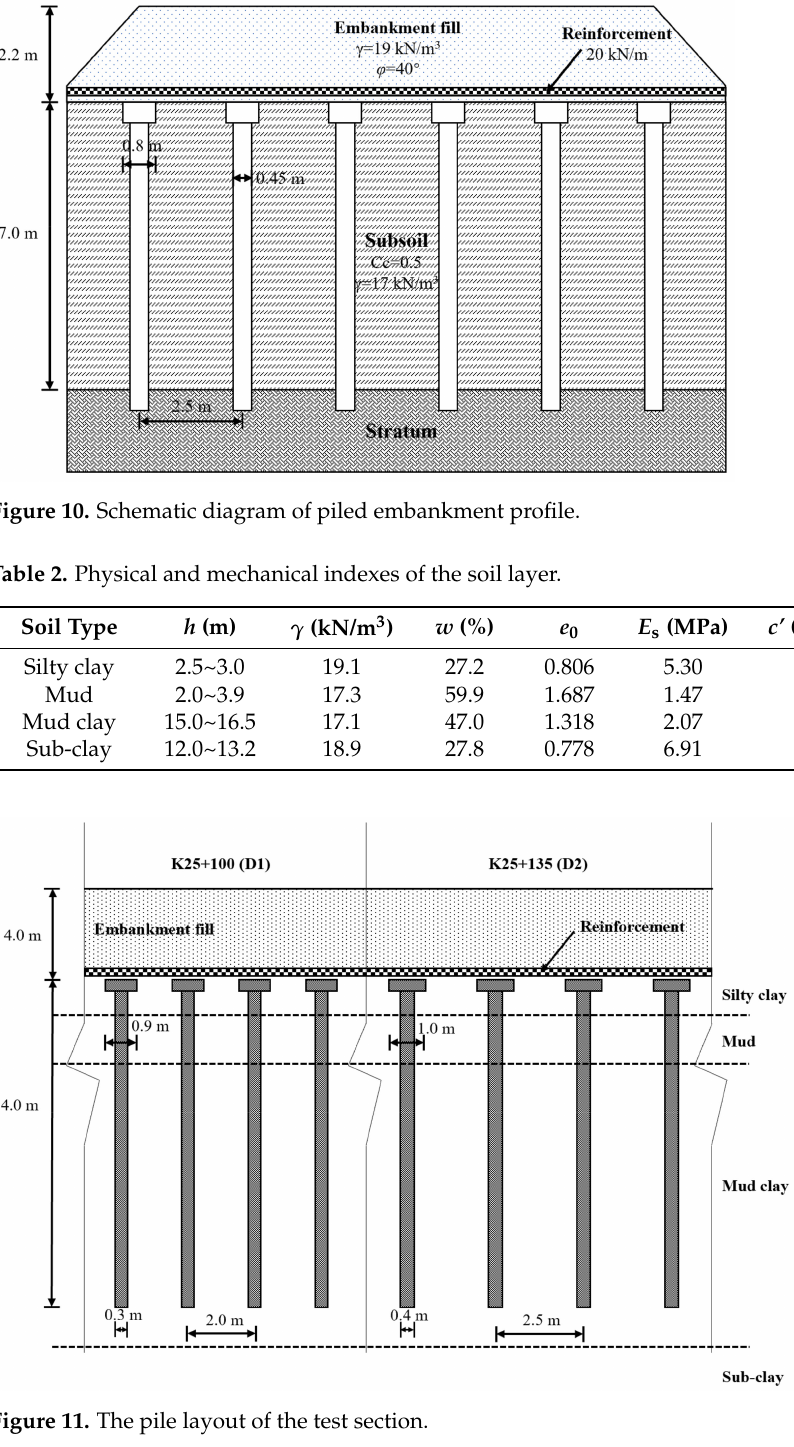
Figure 11. The pile layout of the test